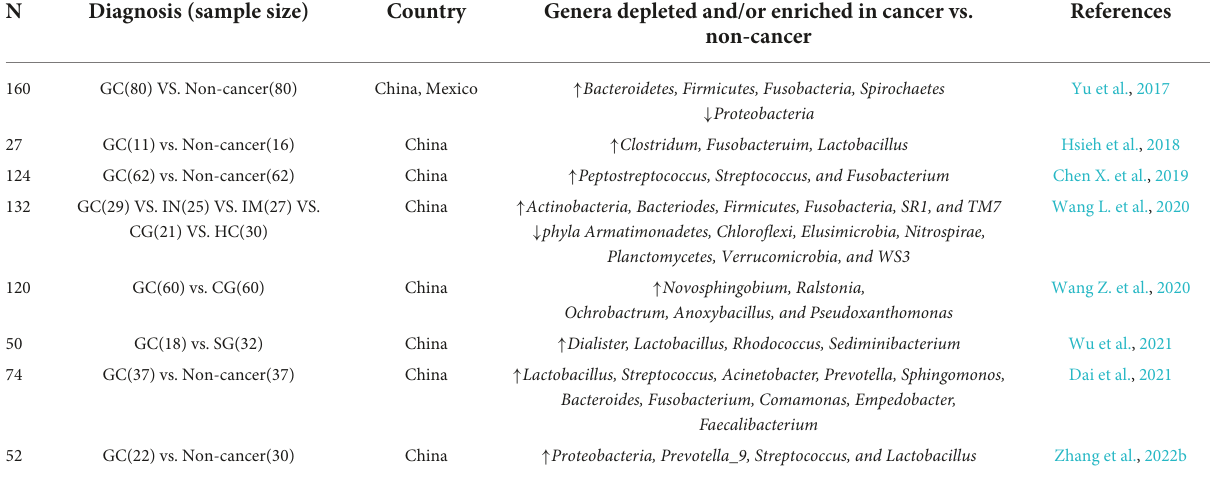
TABLE 1 Genera depleted and/or enriched in cancer vs.